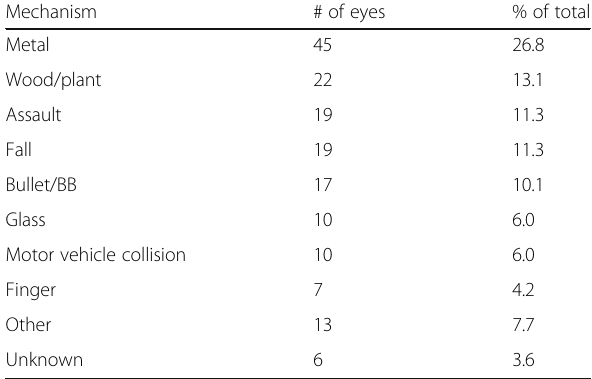
Table 2 Mechanism of open globe trauma